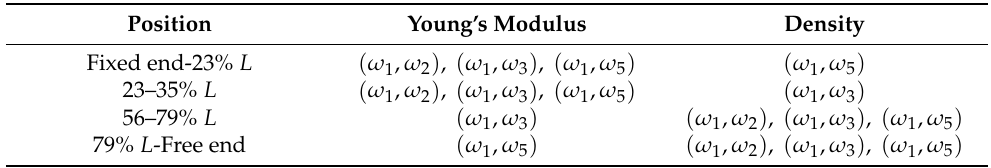
Table 4. Recommended adsorbate center positions and relative natural frequency pairs to measure Young’s modulus and